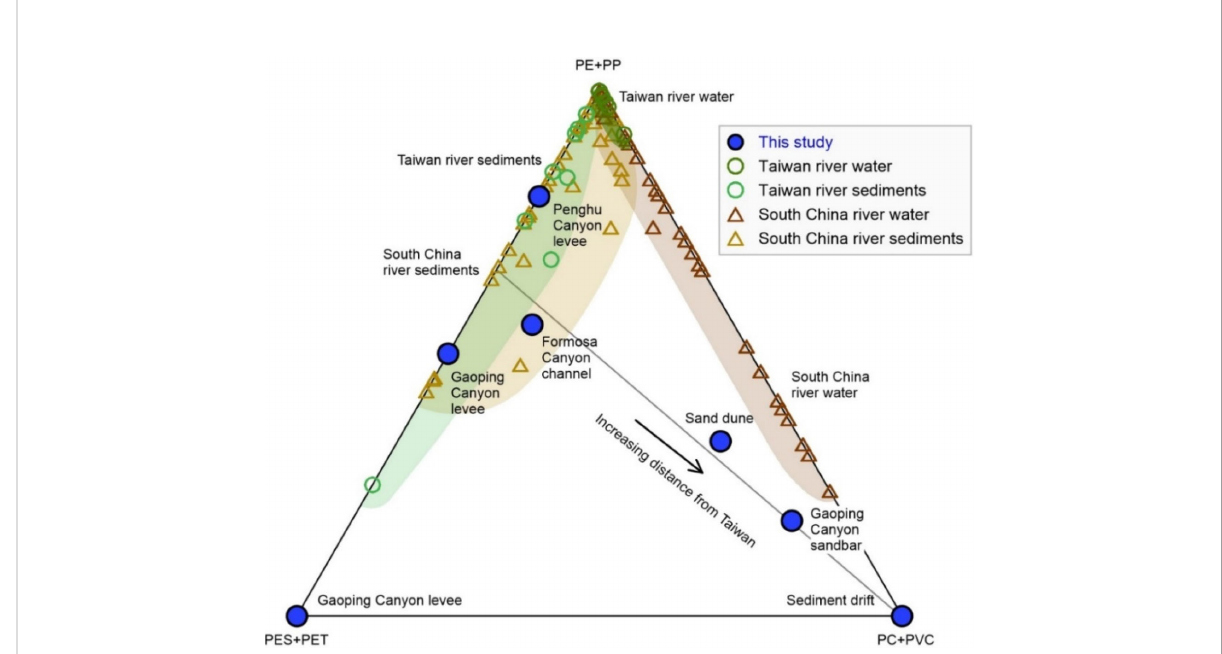
FIGURE 8 Ternary diagram of major microplastic groups of PE+PP, PC+PVC, and PES+PET. PE+PP represents the low-density group with densities less than seawater and in fragment shapes. PC+PVC represents the high-density group with densities greater than seawater and in fragment shapes. PES+PET represents the group in fi ber shapes (some studies have identi fi ed PES as PET). Surrounding river samples for potential microplastic sources are indicated for comparison, including Taiwan river water and sediments (Chen C. F. et al., 2020; Chen et al., 2021), South China river water (represented by the Pearl River) (Tan et al., 2019; Mai et al., 2019; Wu et al., 2020; Li et al., 2021; Huang et al., 2021), and South China river sediments (represented by the Pearl River) (Lo et al., 2018; Lo et al., 2020; Li et al., 2020; Lo et al.,